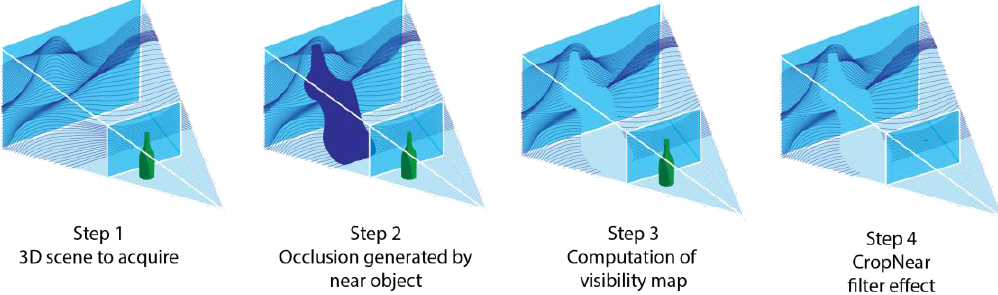
Figure 5. Steps of the process leading to the CropNear filter.